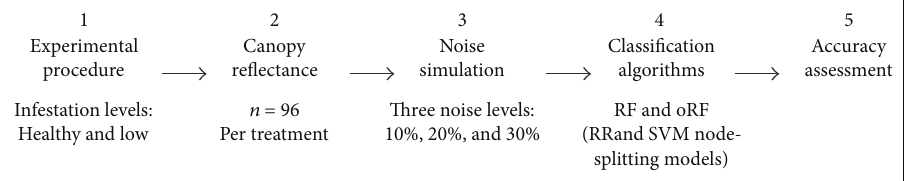
Figure 1: Flowchart outlining the process used to assess the impact of spectral noise on random forest and oblique random forest classi fi cation performance for three weeks.